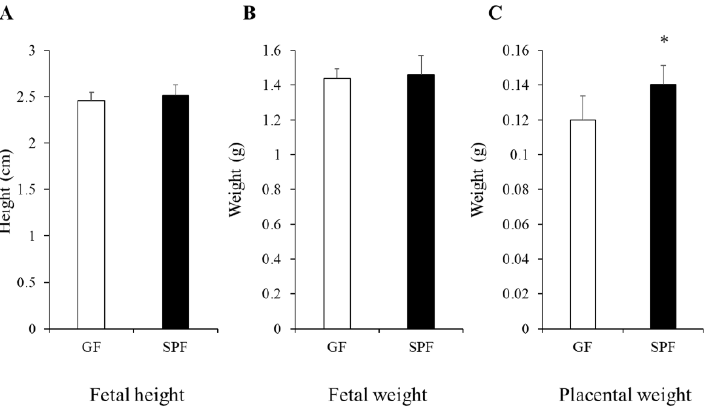
Figure 1. Size of GF and SPF fetus and their placental size. Comparison of body height ( A ) and weight of GF and SPF embryos ( B ). ( A ) The length of the crown-rump length of each fetus were measured. ( B ) Measurement of the weight of each fetus after caesarean section. ( C ) Measuring placental weight after caesarean section. Fetuses at embryonic day 18 (E18) were collected from GF and SPF pregnant mothers. The data are presented as the mean ± SD ( n = 8, t -test, * p < 0.05).